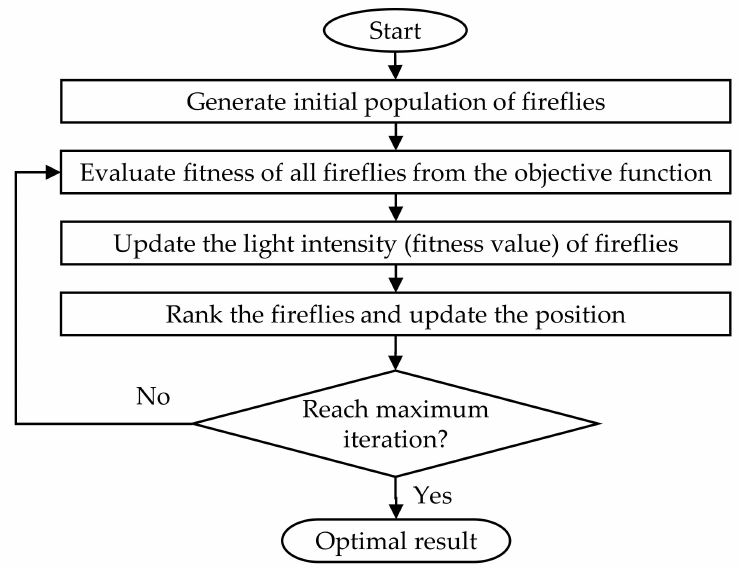
Figure 8. Flowchart of firefly